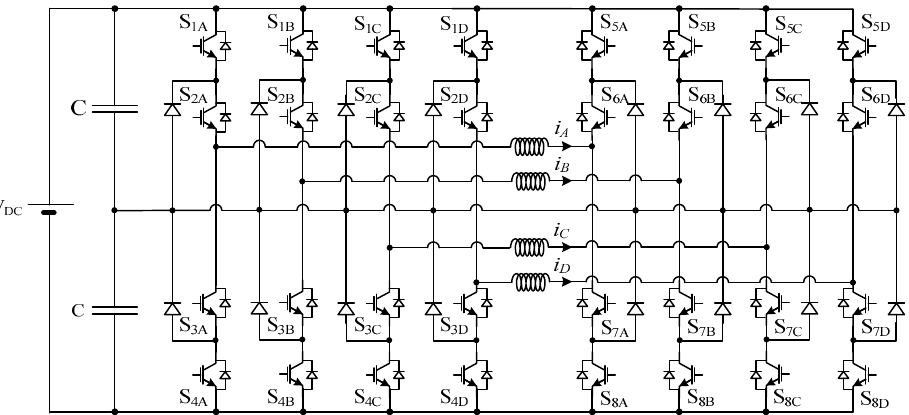
Figure 28. Fault-tolerant multilevel topology proposed by [93], combining multilevel operation, bidirectional current excitation of SRMs and changes in the control strategy. Both open- and short-circuit failures in controlled power semiconductors are covered by this topology.